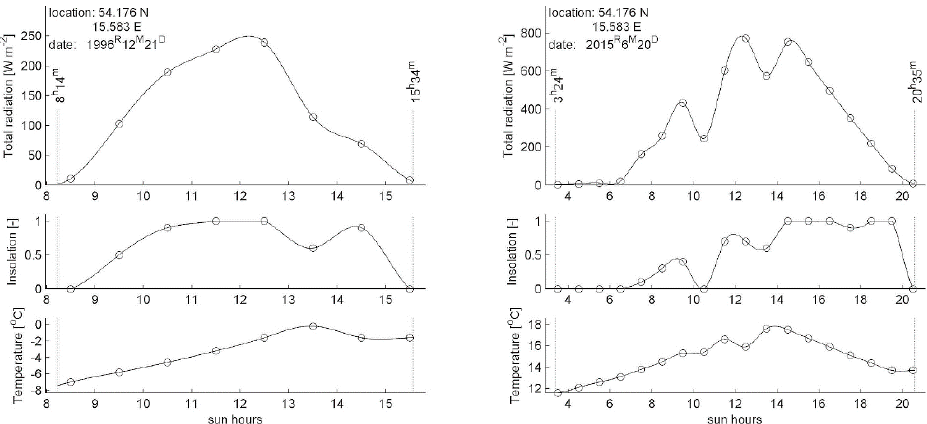
Figure 1. Total radiation, insolation and air temperature on selected days.